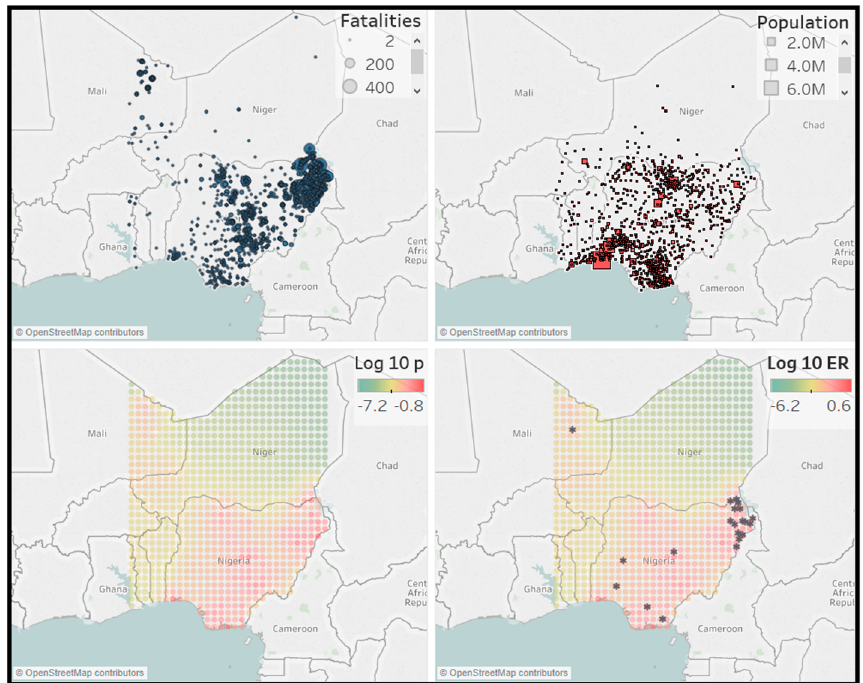
Figure 12. Forecasts for West Africa. Top left: event catalog 2012–2016. Top right: City map with cities with 1000+ population. Bottom left: spatial background distribution estimated from the data from 2012–2016. Bottom right: forecast for the expected number of events with 𝑀 ≥ 4 in each cell in the year 2017, together with the locations of the actual conflicts that have taken place with 𝑀 ≥ 4 .